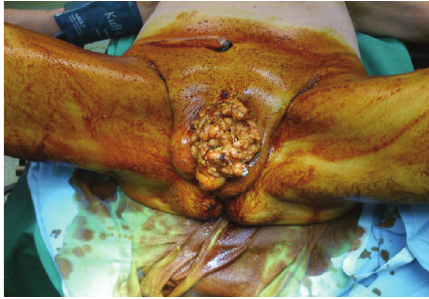
Figure 1: Massive cauliflower-like penile mass with several urinary fistulae making the penile shaft indistinguishable.